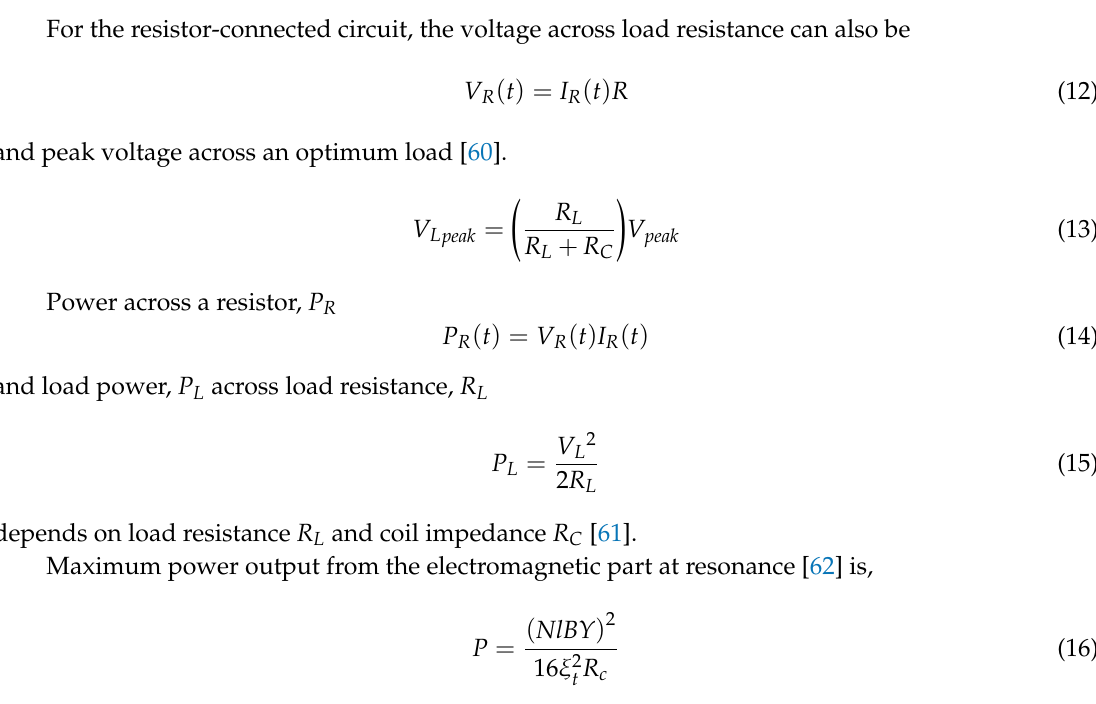
Figure 4. Multi-layered wound coil cross-section.